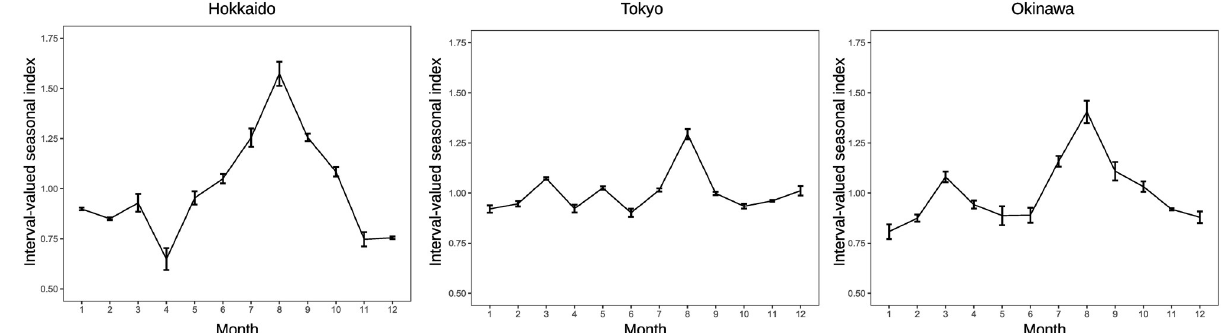
Fig 5. Interval-valued seasonal indices of domestic guests for tourism in Hokkaido, Tokyo and